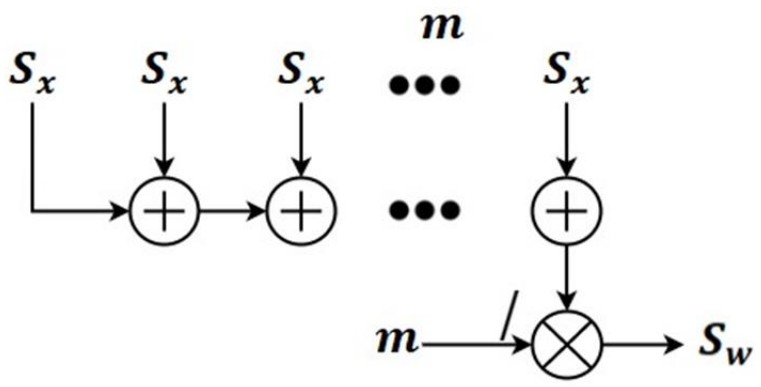
Figure 4. Pictorial representation of S w .